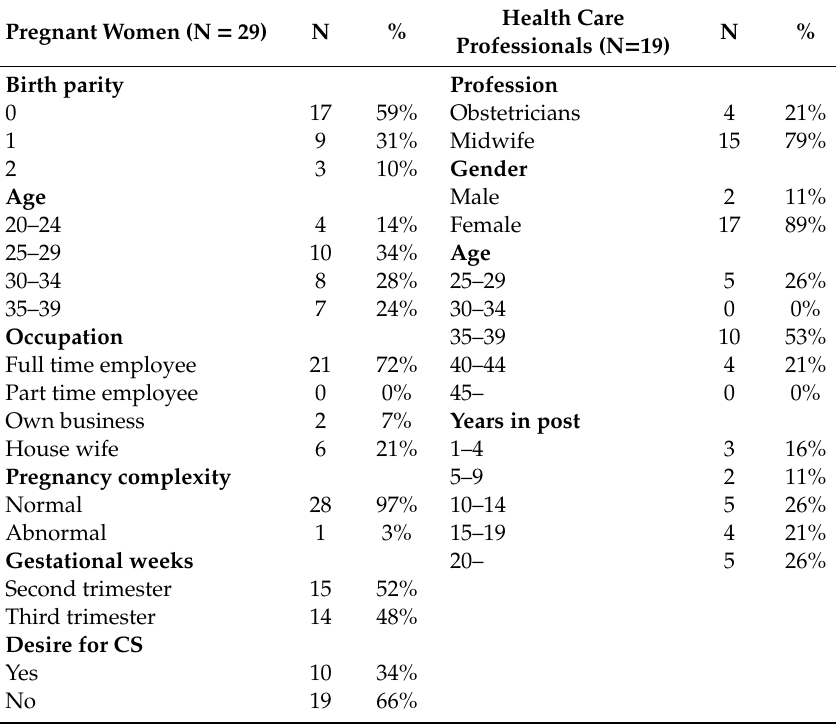
Table 1. Characteristics of